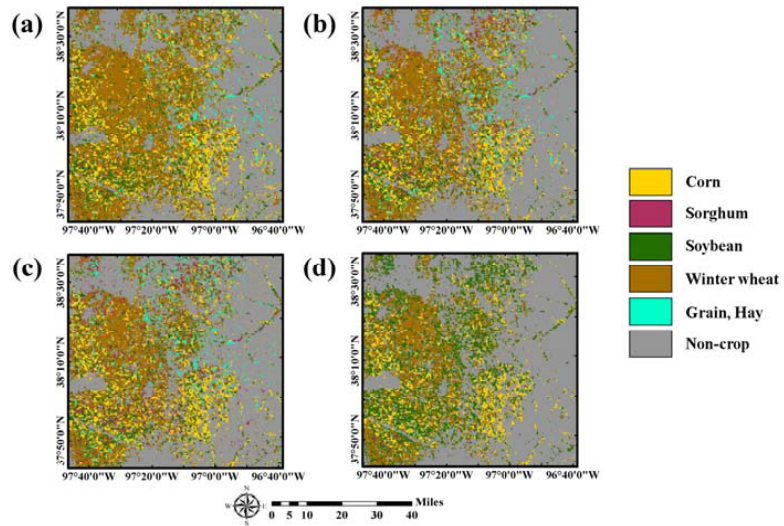
Figure 6. Final classification results of a self-learning approach with different past CDLs: ( a ) 5-year (2010 to 2014); ( b ) 4-year (2011 to 2014); ( c ) 3-year (2012 to 2014); and ( d ) 2-year (2013 to 2014).